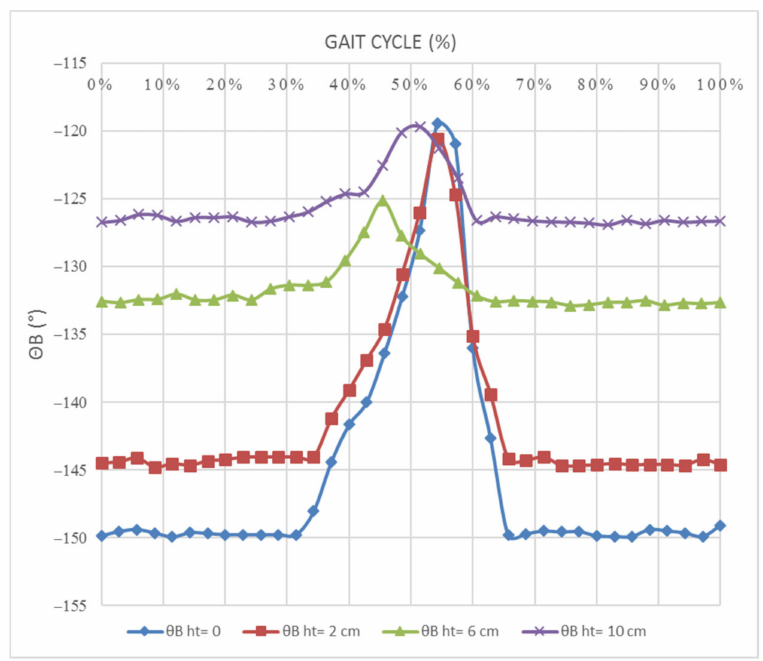
Figure 5. Metatarsophalangeal joint kinematics on the sagittal plane ( ◦ ) during a full gait cycle for heel heights 0, 2, 6 and 10